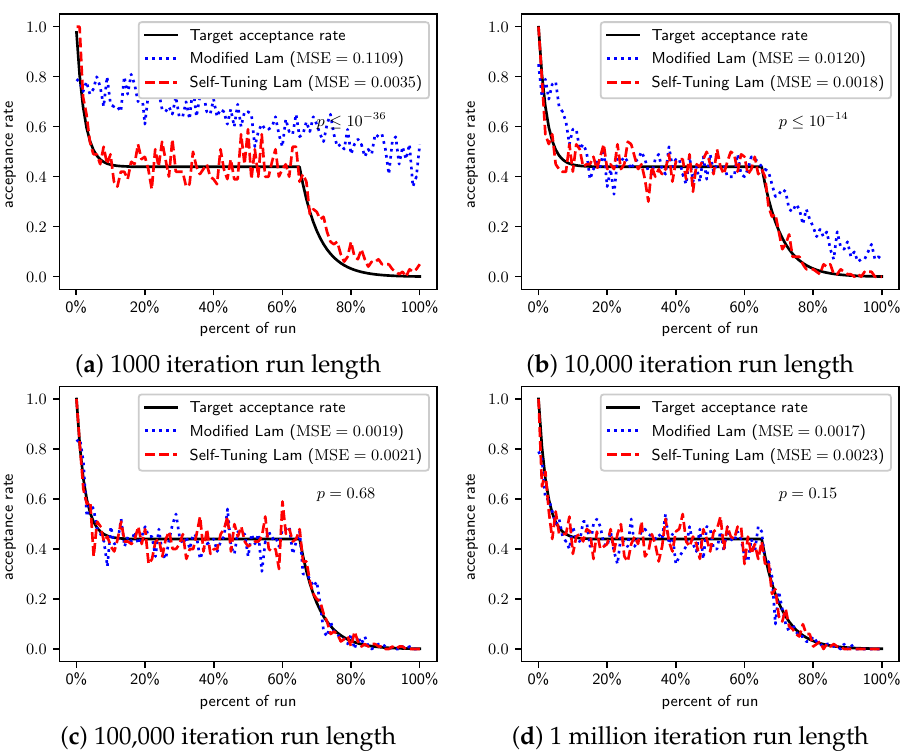
Figure 17. Minimize g 1 ( x ) : Self-Tuning Lam, Modified Lam, and target acceptance rates for